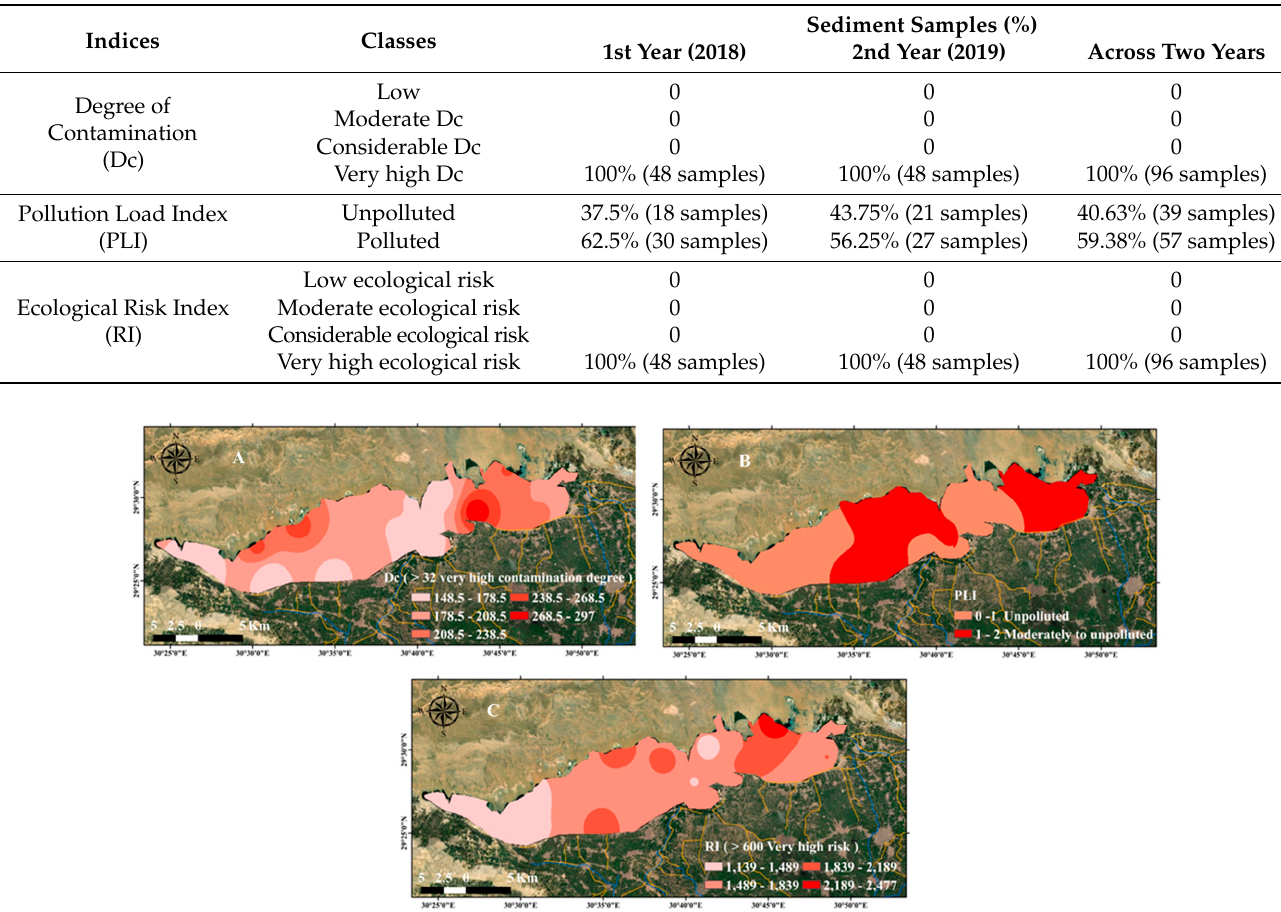
Table 7. Assessment of surface sediments of Qaroun Lake according to categories of degree of contamination (Dc), pollution load index (PLI), and potential ecological risk index (RI).